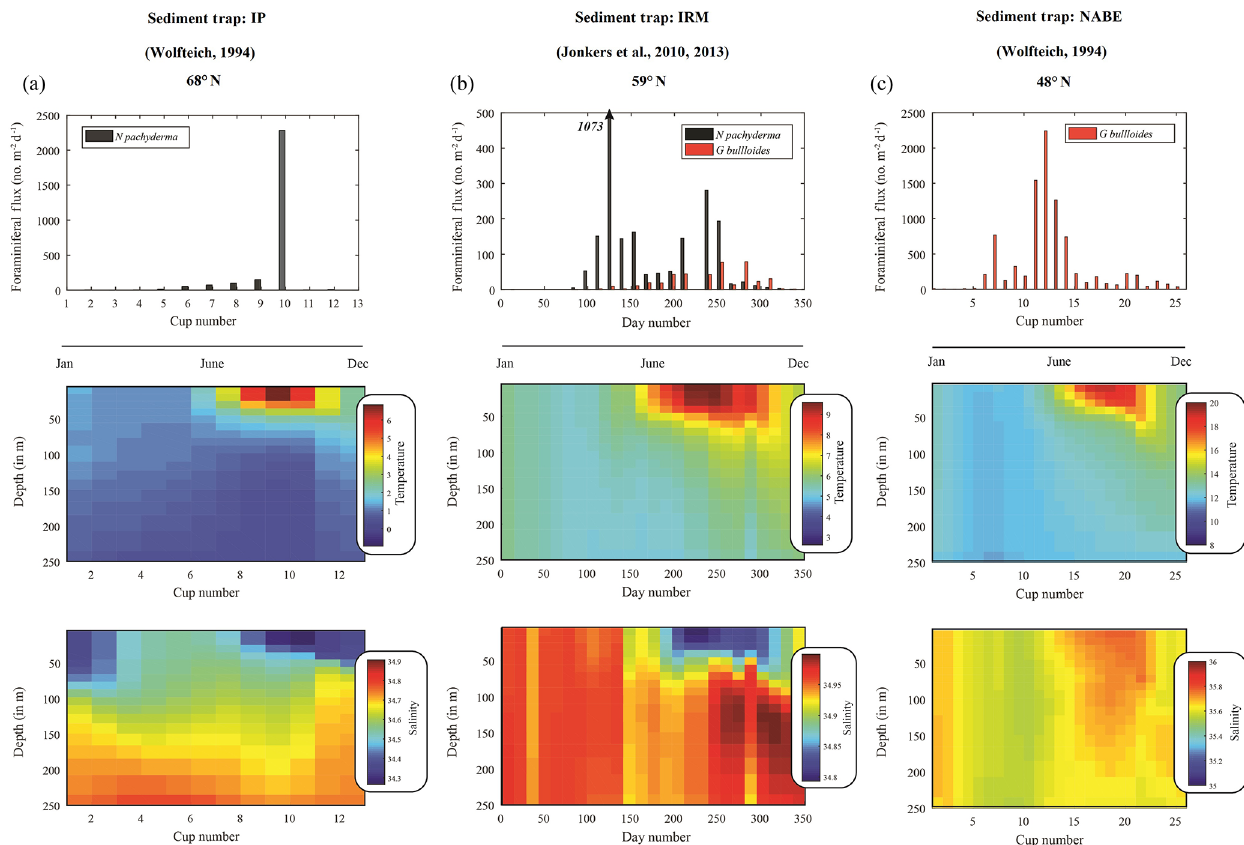
Figure 8. Seasonal succession in the modern North Atlantic. Top panels indicate fluxes of N. pachyderma (grey) and G. bulloides (blue) from sediment traps in (a) the polar Greenland–Norwegian Sea (Wolfteich, 1994), (b) subpolar Irminger Sea (Jonkers et al., 2010, 2013; Jonkers and Kuˇcera, 2015) and (c) temperate mid-North Atlantic (Wolfteich, 1994); same labels as in Fig. 1. Middle and bottom panels represent the temperature and salinity from Ocean ReAnalysis System 4 (ORAS4) (Balmaseda et al., 2013). For panels (a) and (c) , cups have been rearranged to progress from January to December. The fluxes, temperature and salinity given represent an averaging over the trap deployment